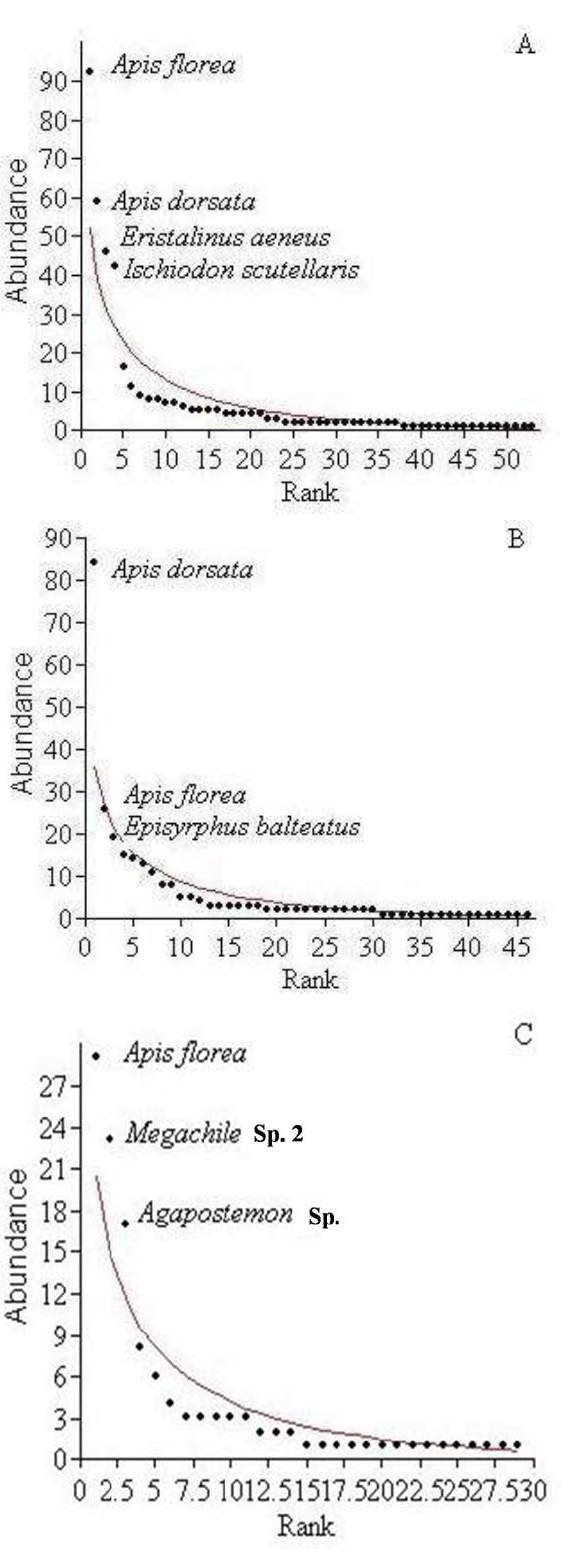
F IGURE 2. Rank-abundance (total numbers over